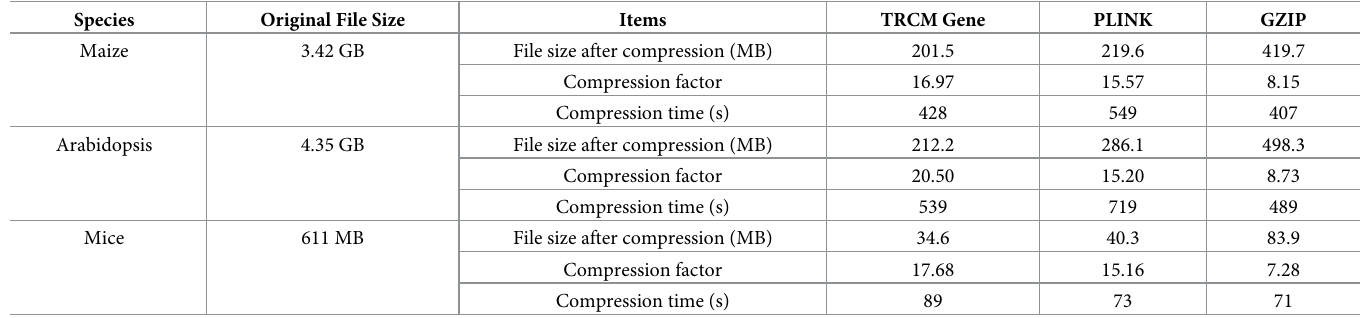
Table 2. Performance of TRCMGene compared with that of two other compression methods.